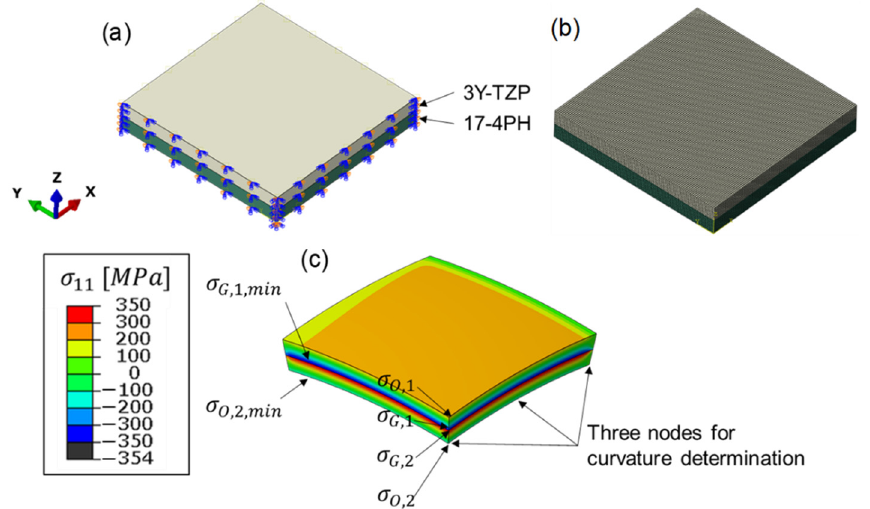
Figure 7. ( a ) The assembly of two-layer MCLs and boundary conditions. ( b ) Hexahedral mesh of laminates. ( c ) The curvature with a deformation scale factor of 10 and the stress distribution in the two-layer laminate.